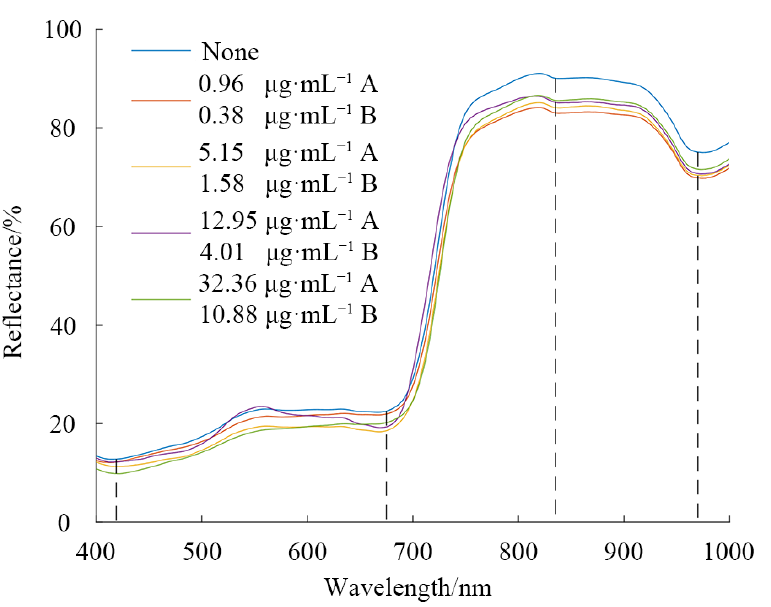
Figure 4. Vis/NIR spectra of different compound pesticide residue content on the Hami melon surface. A is lambda-cyhalothrin; B is beta-cypermethrin.